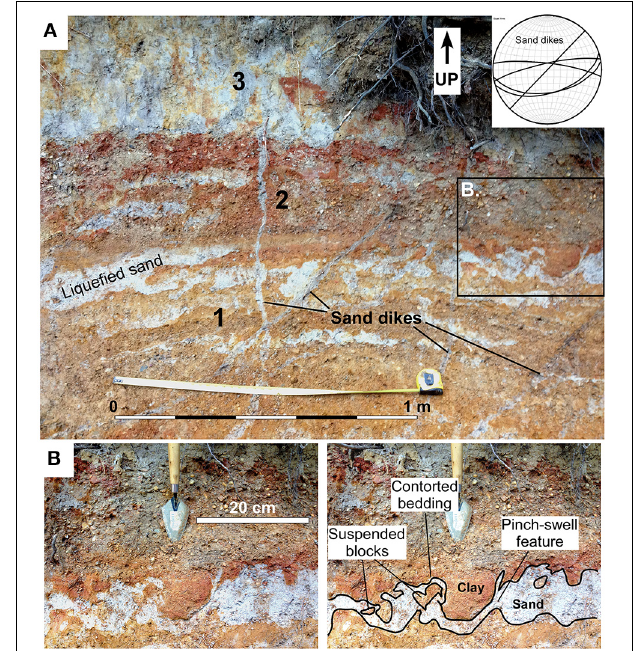
FIGURE 11 | Site L (South fork of Clear Creek, 33.50916 ◦ N, 91.82417 ◦ W). (A) Photograph of a subvertical exposure of Middle Pleistocene river (Arkansas River?) alluvium showing clastic dikes and sills, convoluted bedding, pinch and swell features, and suspended blocks. Looking south. Unit 1, Point-bar, medium interbeds of clay and fine/medium sand; Unit 2, Channel, medium-bedded gravel; Unit 3, Overbank, massive clay (light gray features are reduction zones along desiccation cracks). Tape is extended 1 m. Inset shows lower hemisphere stereogram of great circles plots of sand dikes at this site. (B) Photograph details showing convoluted bedding, suspended blocks, and pinch-swell features. Location of (B) is shown on (A)